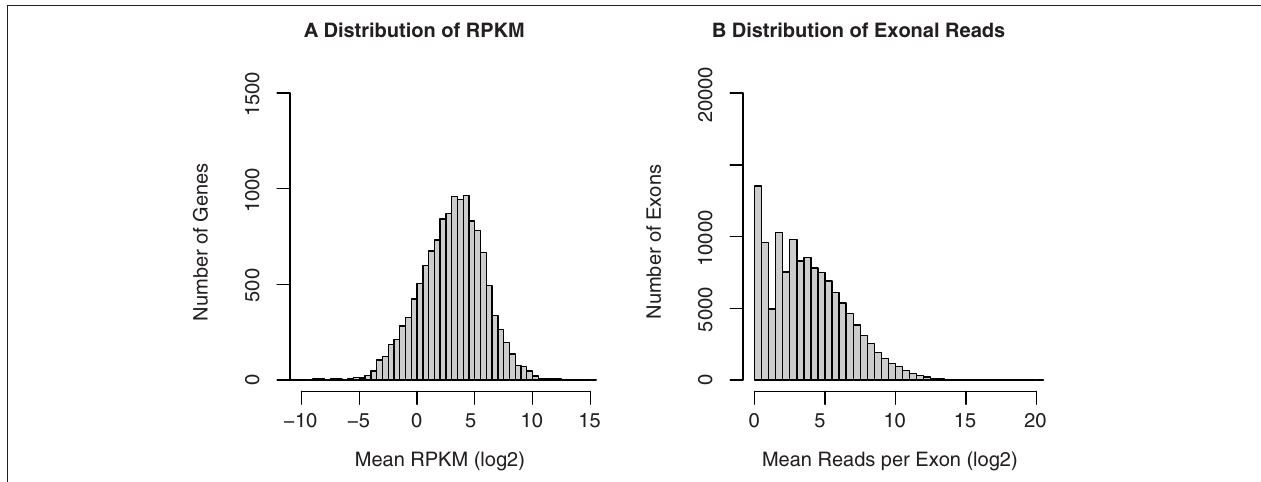
FiGuRe 4 | RNA-seq gene expression profiles of GABAergic neurons projecting from nucleus accumbens shell to ventral pallidum. The same RNA samples used in the microarray study were amplified before “bar-coded” cDNA libraries were prepared for SOLiD sequencing. All four samples were then pooled and sequenced in the same run. The 50-bp sequencing reads were